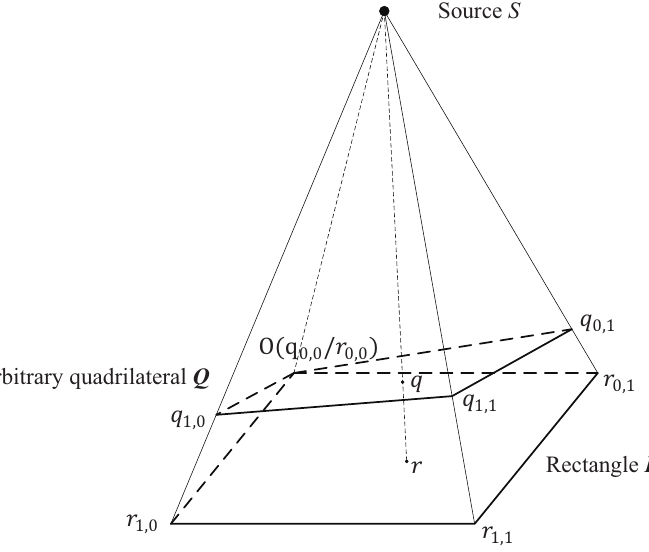
Figure 1. Schematic diagram of the center